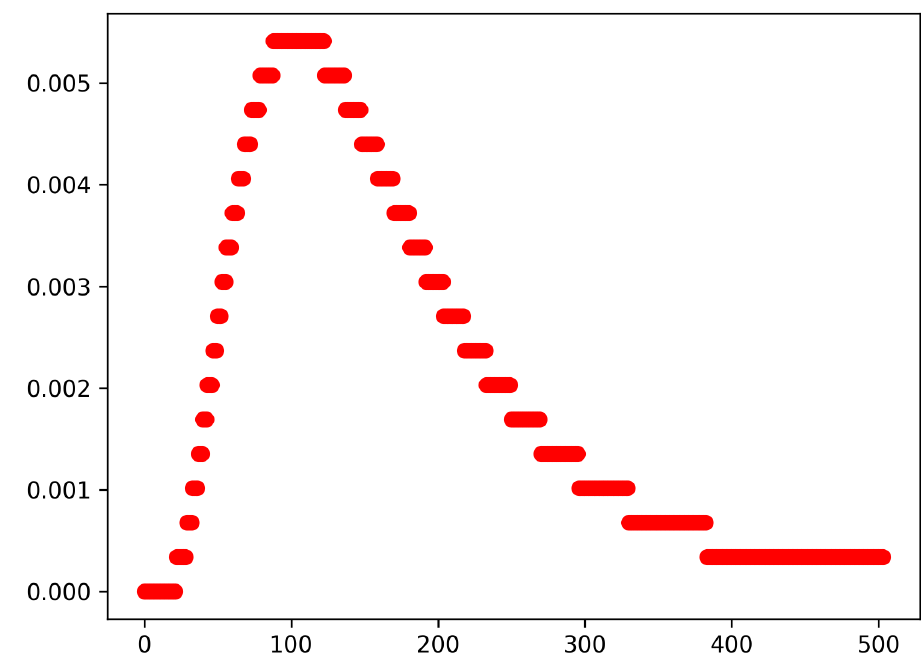
Figure 1. The empirical density function of the sequence LognormalSeq ( 5,0.6,3000 ) .